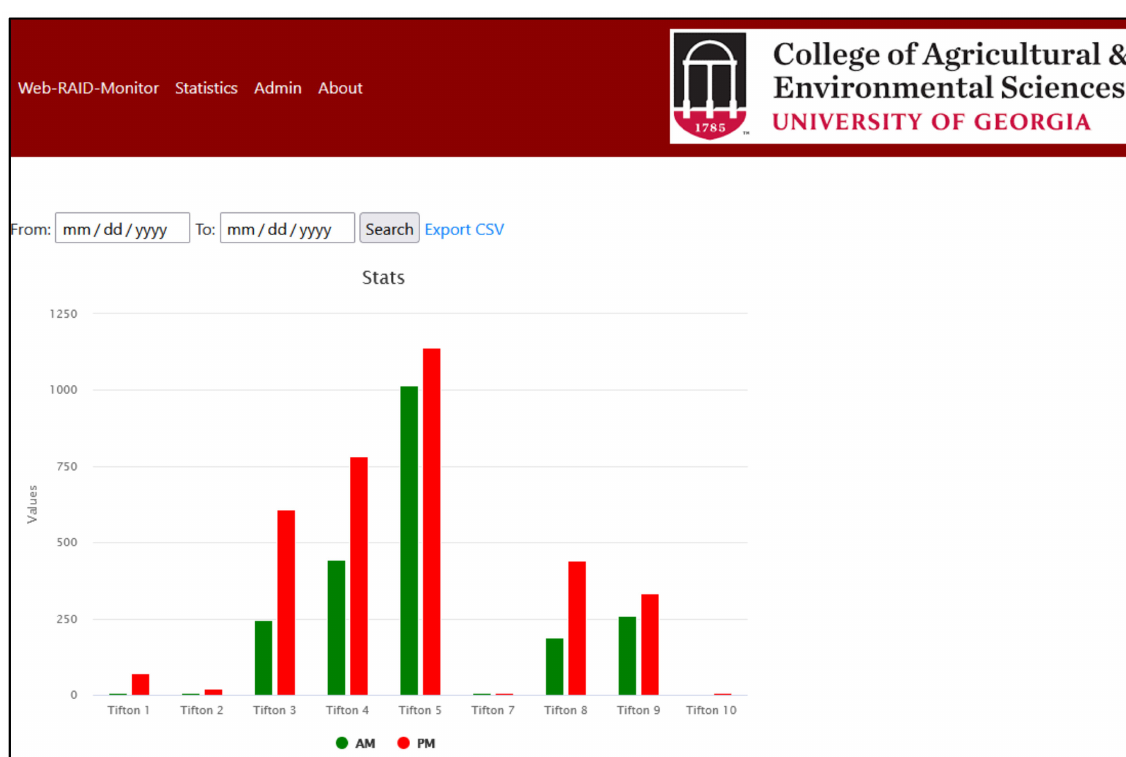
Figure 9. Results sorted according to date and location.